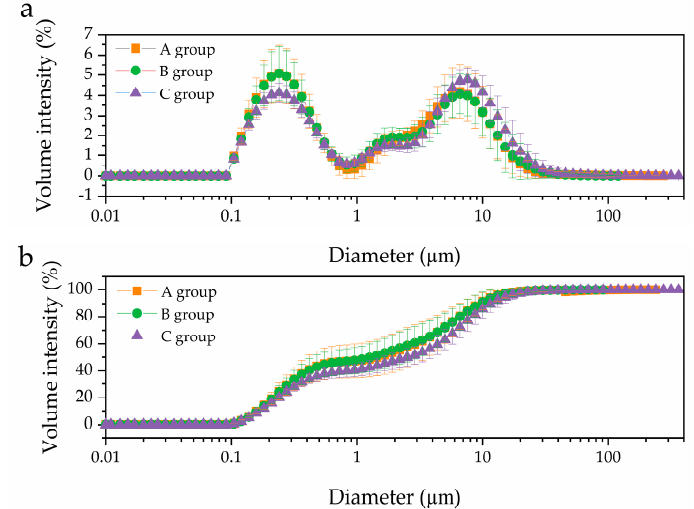
Figure 1. Comparison of the size distribution of human milk fat globules in different groups. ( a ) volume distribution, and ( b ) cumulative volume, distribution. A group, n = 11; B group, n = 11; C, group, n = 12.